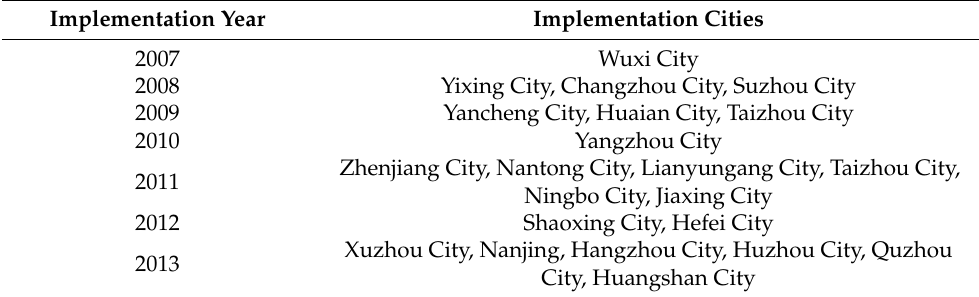
Table 1. List of cities implementing the river chief